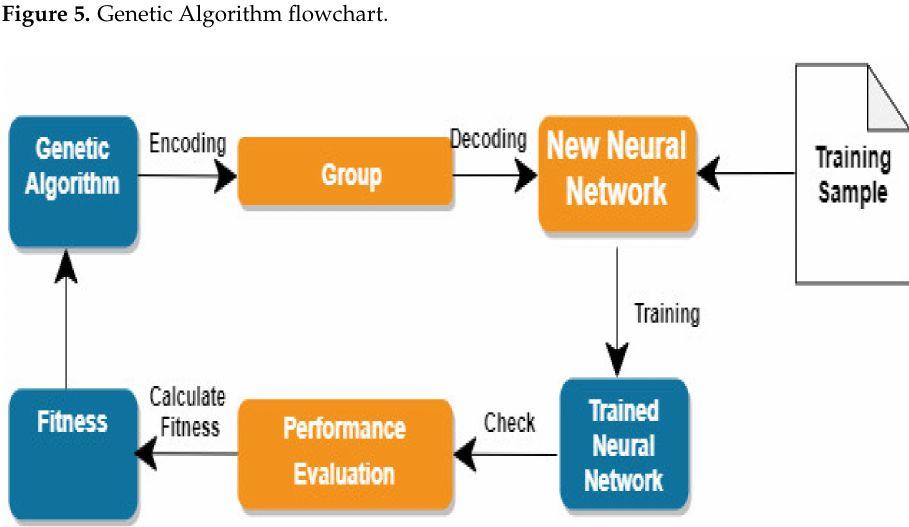
Figure 6. Mapping of the Genetic Algorithm with the neural